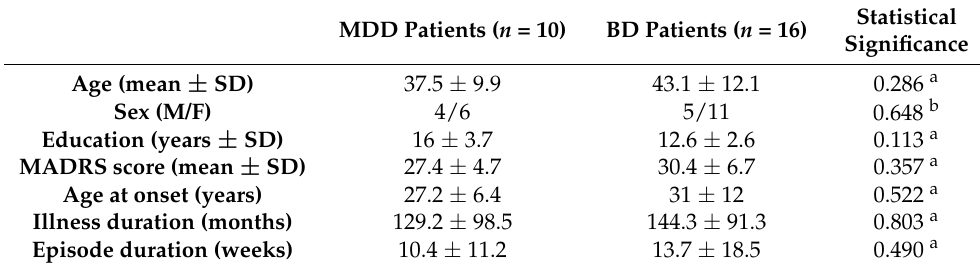
Table 2. Demographic and clinical characteristics of the two depression